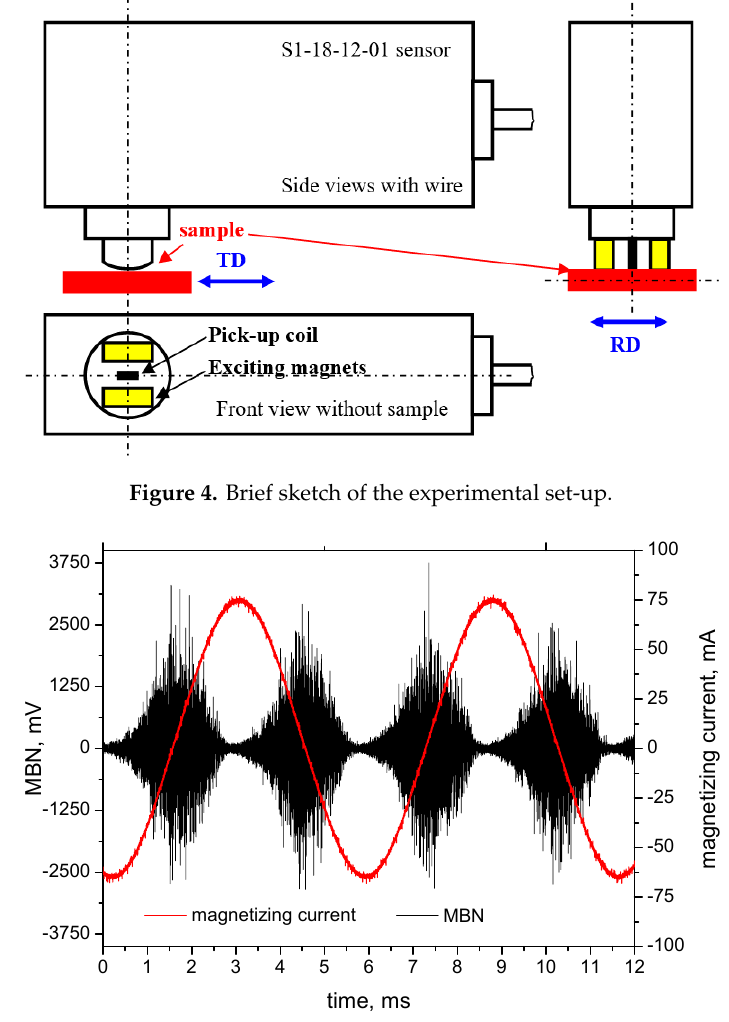
Figure 5. Magnetic Barkhausen noise (MBN) signal measured in rolling direction (RD) for ε = 2.5%.